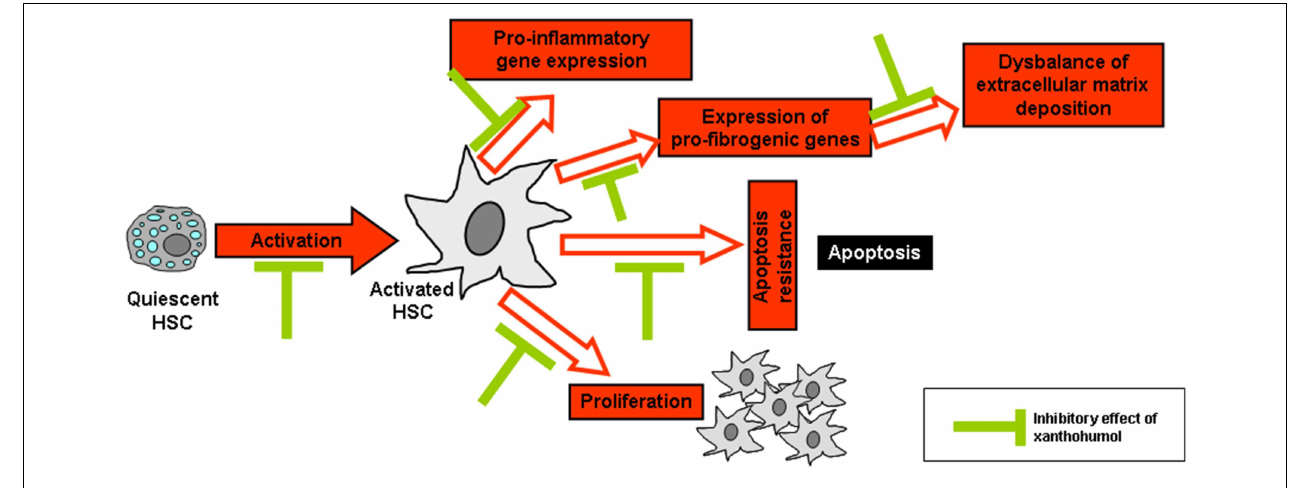
is known that XN inhibits pro-inflammatory and pro-fibrogenic ( Dorn et al., 2010a, 2013 ) gene expression and HSC activation (Yang et al., 2013) thereby preventing the excessive formation and deposition of extracellular matrix as well as the activation and proliferation of HSC. In addition, XN was shown to interfere with HSC apoptosis (Dorn et al.,